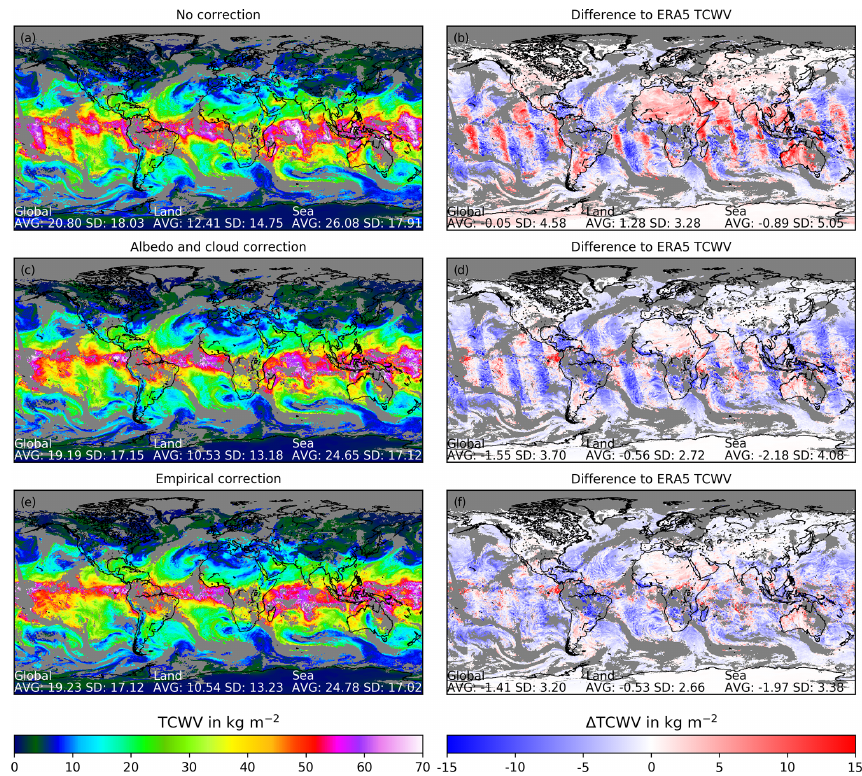
Figure 2. Visualization of the effects of the correction on the AMC-DOAS S5P TCWV on 23 February 2020. Grey areas are data gaps mainly due to the filtering. Panel (a) shows the retrieved AMC-DOAS S5P TCWV with no corrections applied; (c) shows the AMC-DOAS S5P TCWV with albedo and cloud correction as explained in the text; (e) shows the empirically corrected AMC-DOAS S5P TCWV after the cloud and albedo correction. Panels (b) , (d) and (e) show the difference of the AMC-DOAS S5P TCWV in (a) , (c) and (e) to the ERA5 TCWV (AMC-DOAS S5P TCWV − ERA5 TCWV).